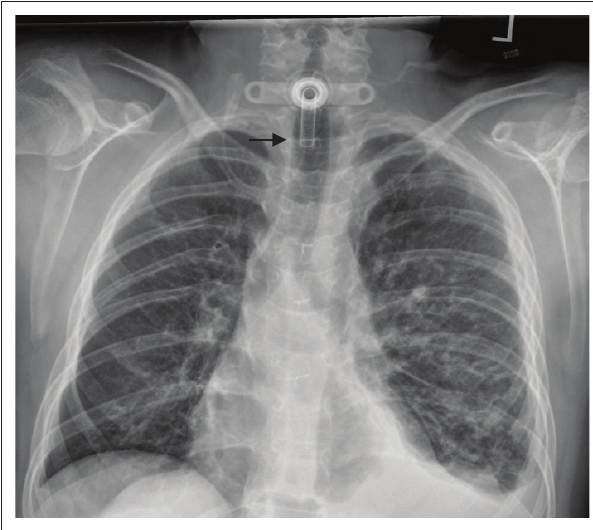
FIGURE 2: Chest radiograph showing an accurately positioned tracheostomy tube